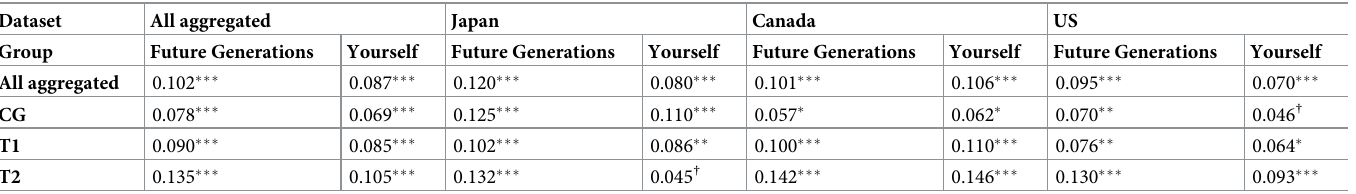
Table 4. Correlation coefficients between post-intervention effect in attitude change ( D ) and perceptions of benefiting from the older generations. Dataset All